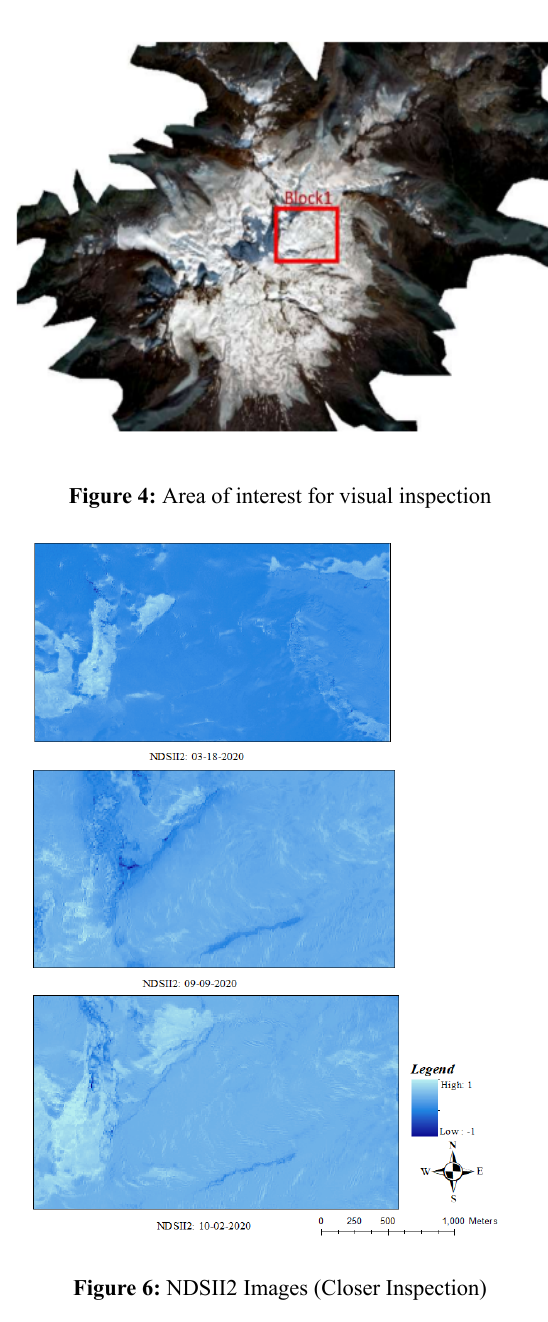
Figure 6: NDSII2 Images (Closer